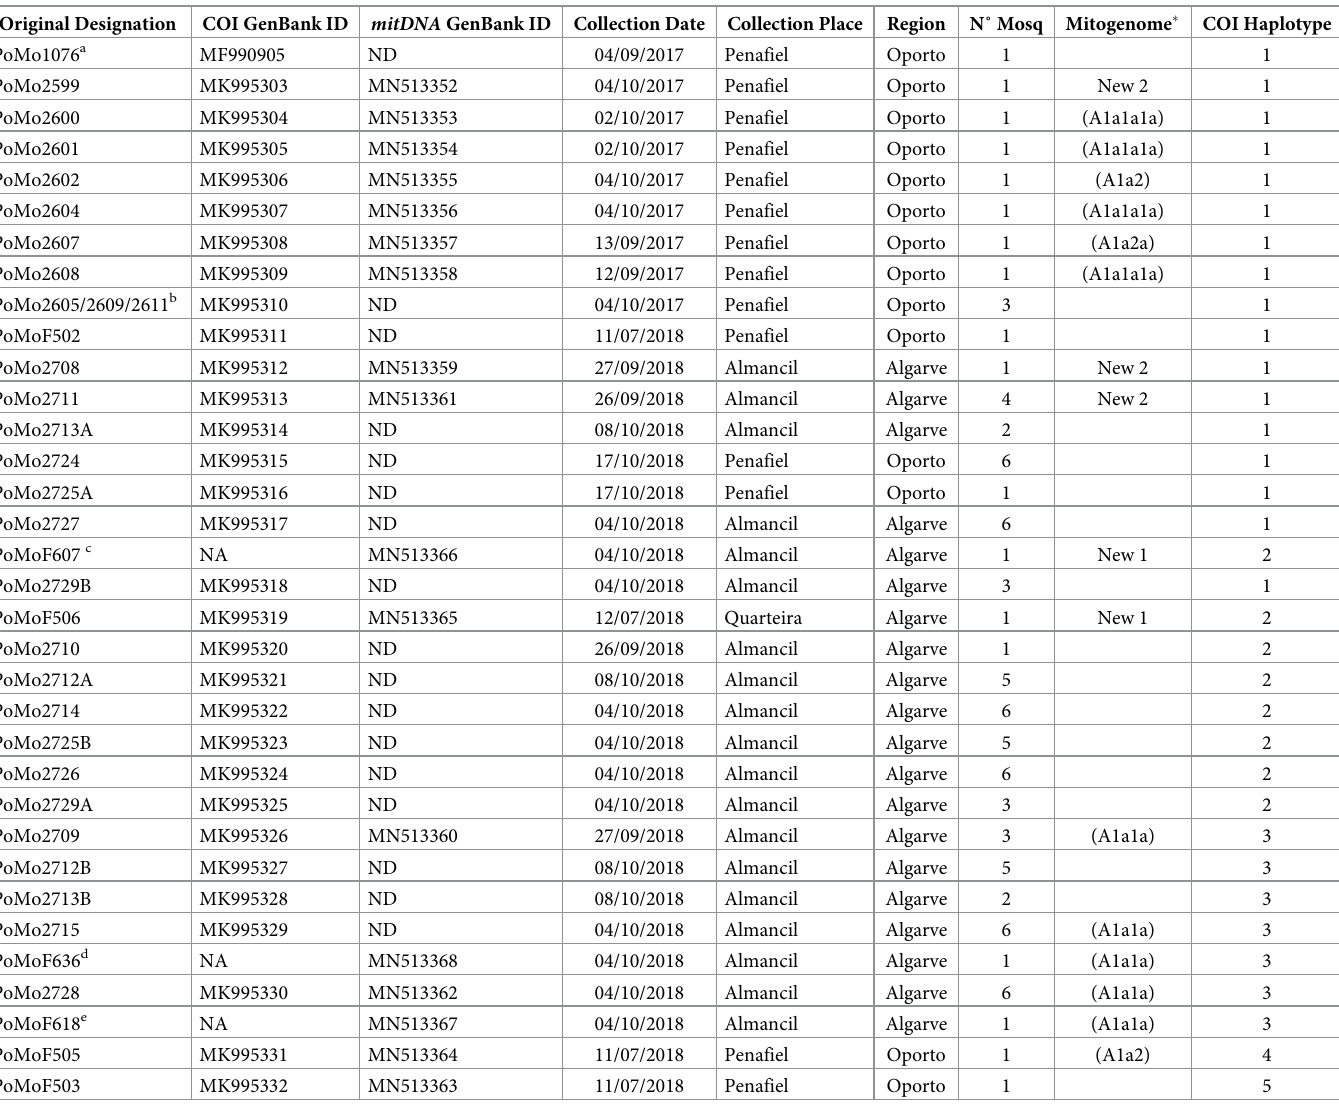
Table 1. Aedes albopictus samples collected in